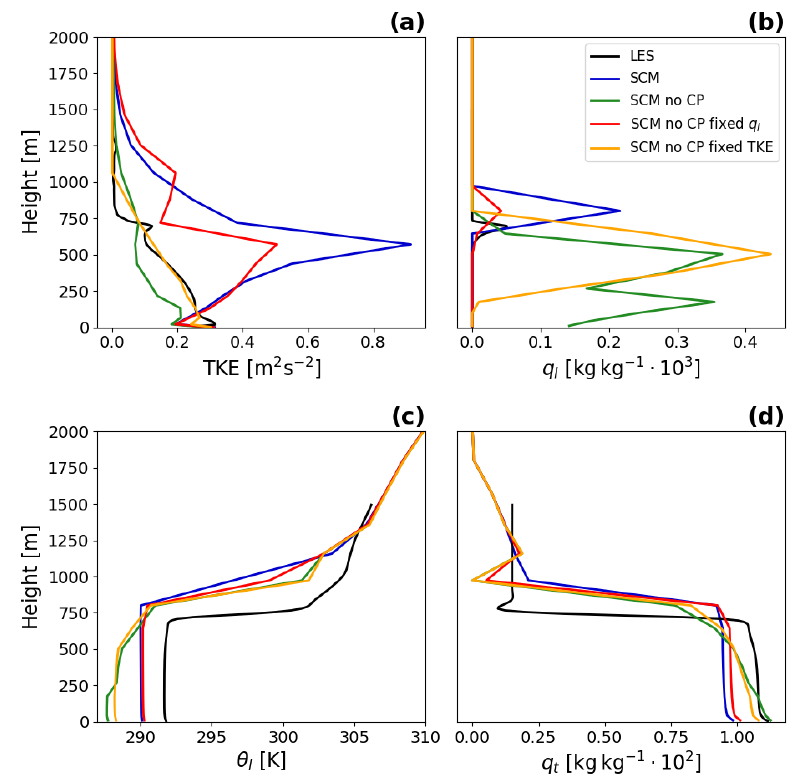
Figure 8. As in Figure 7, but one-hour mean vertical profiles of TKE ( a ), liquid water content ( b ), liquid water potential temperature ( c ), and total specific water content ( d ) after 20 h of integration.